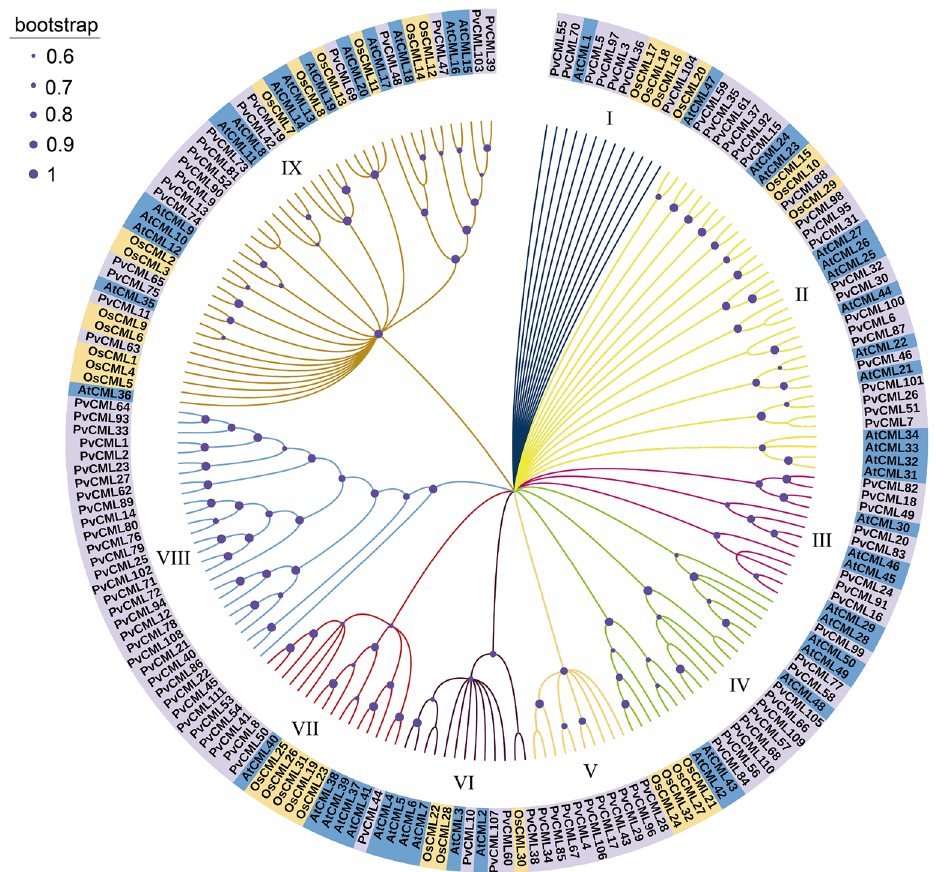
Figure 4. Maximum likelihood tree of CML proteins from P. Vulgaris , O. sativa and A. thaliana . The CML proteins in the branches from different species were indicated by different color: purple, P. Vulgaris ; yellow, O. sativa ; blue, A. thaliana . Different colors of branches represented different subfamilies. The size of the blue circle represented the bootstrap